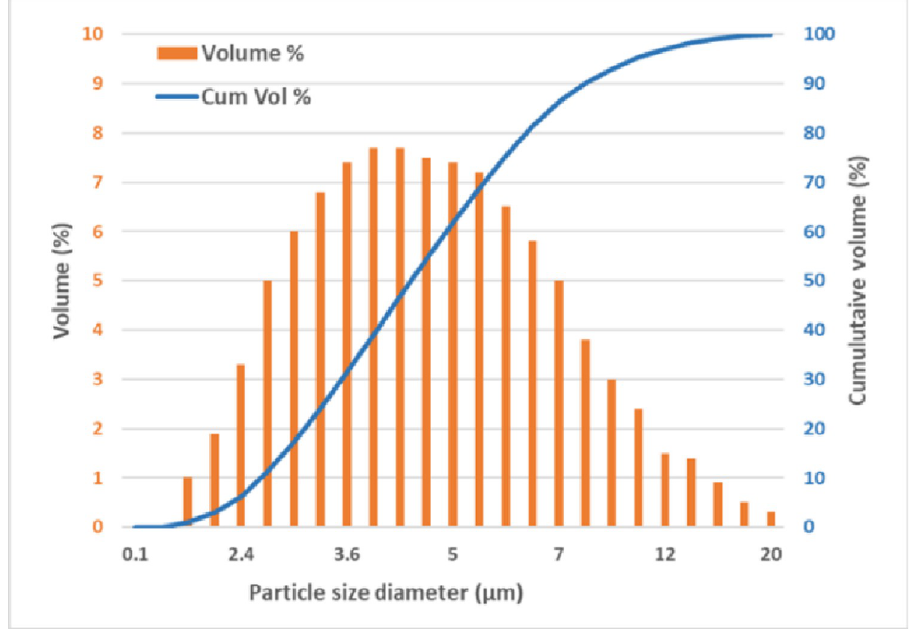
Fig 4. The distribution of nebulized NaCl particles with a median mass aerodynamic diameter (MMAD) of 5.3 μ m is representative of typical aerosolized virus particle